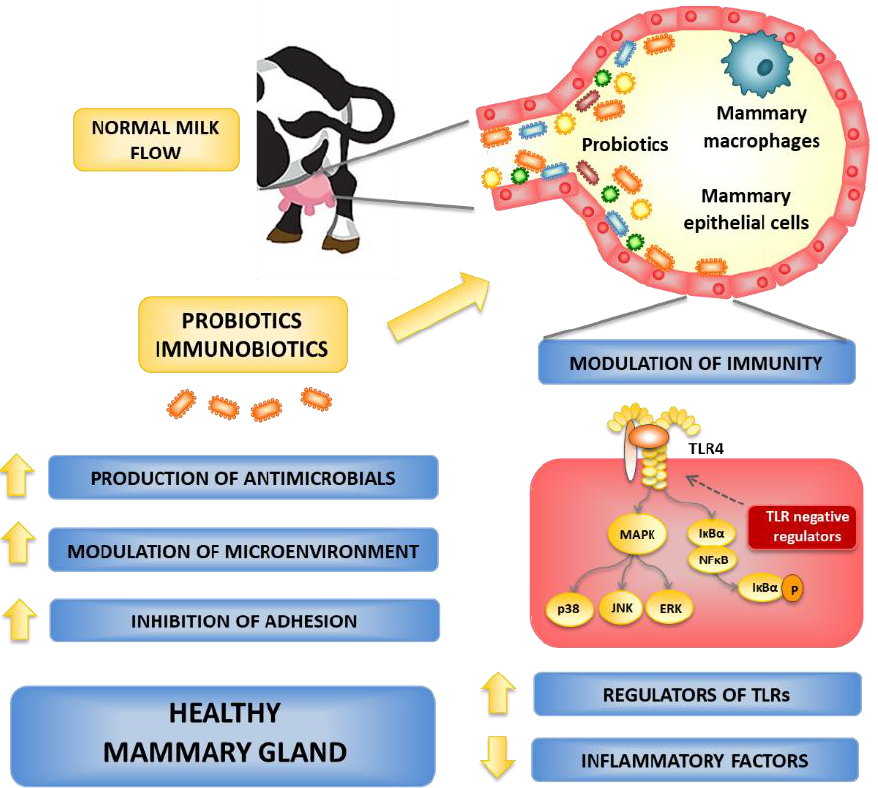
Figure 2. Effect of probiotic and immunobiotic microorganisms on the susceptibility to bovine mammary gland infections.